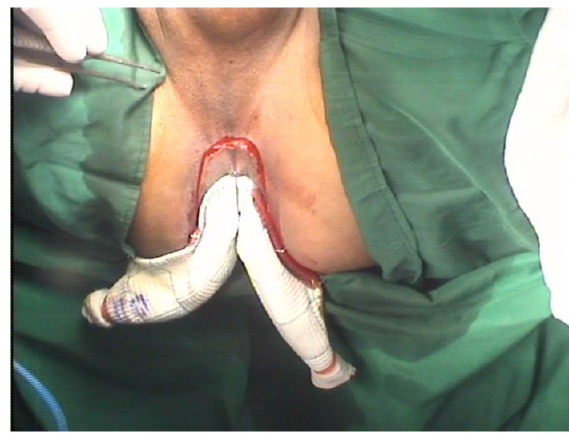
Figure 2. Perineal incision above anus.